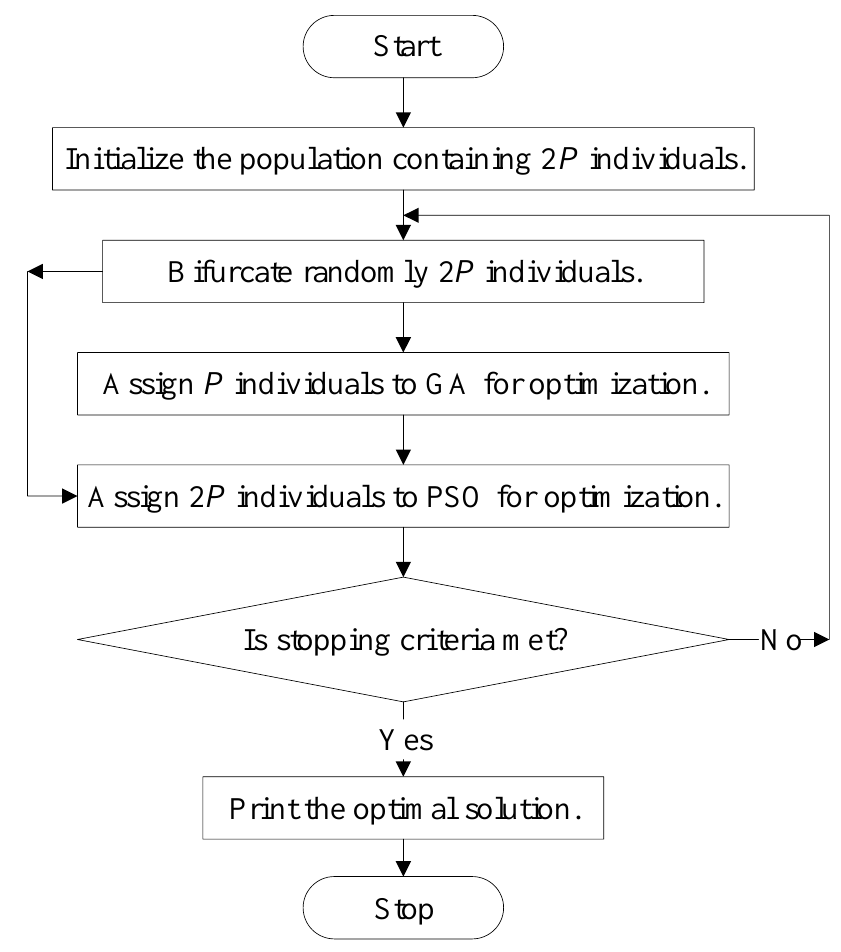
Figure 3. Flow chart for a hybrid GA-PSO based approach.